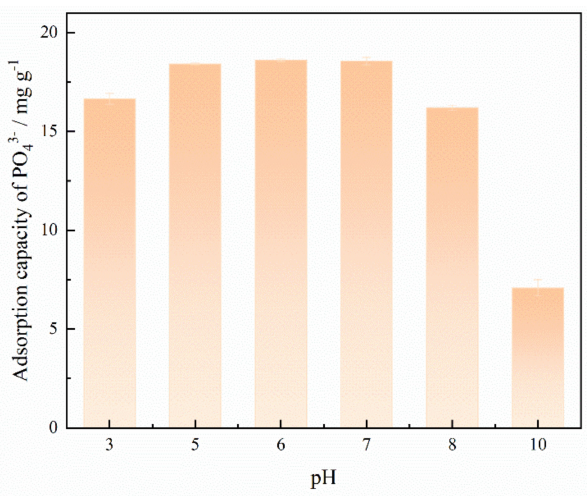
Figure 5. Effect of pH on phosphorus removal